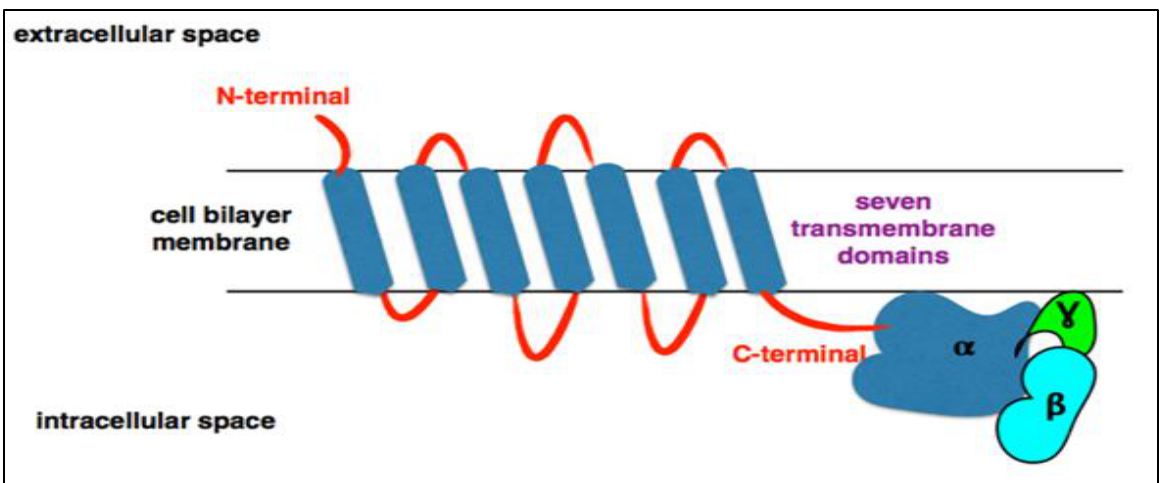
Figure 1 . Depiction of the general structure of a typical G protein-coupled receptor showing the 7 transmembrane α- helices spanning the cell membrane and linked to the heterotrimeric G protein. Each receptor has an extracellular amino-terminal and an intracellular carboxyl domain (11)